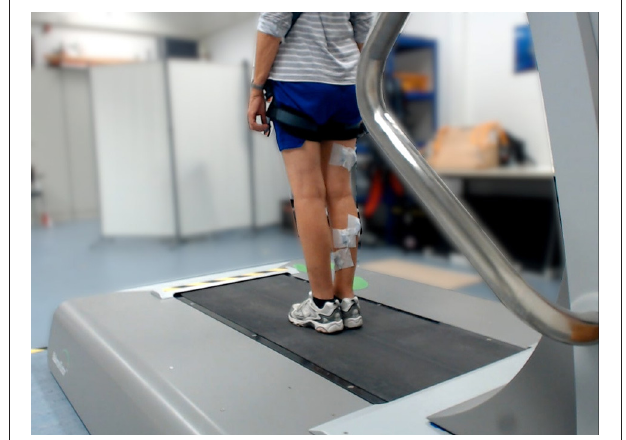
FIGURE 3 | The perspective of the